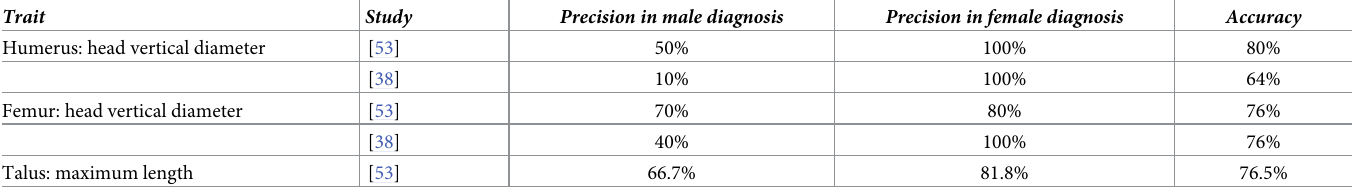
Table 7. Application of the cut-off point calculated from Gonc¸alves et al. [53] and Van Vark [38] to the present study series.